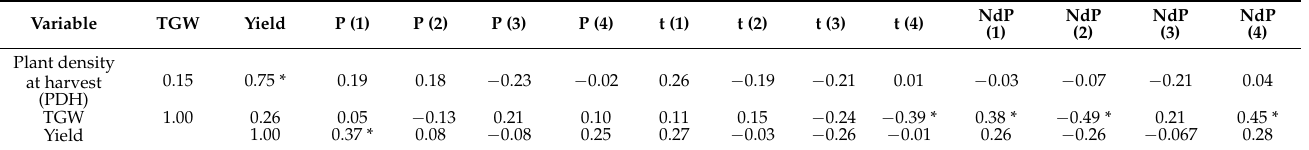
Table 4. Correlations between elements of the yield of winter wheat and selected meteorological